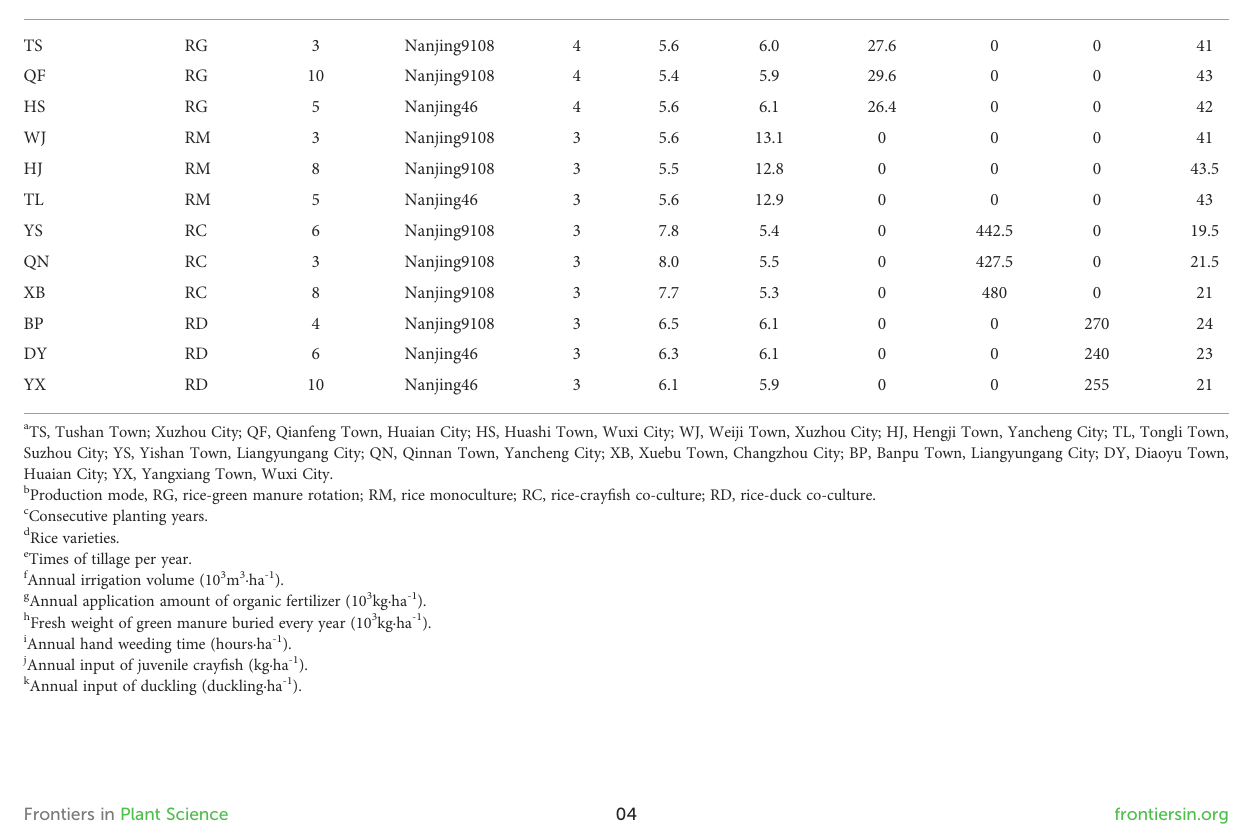
TABLE 1 The consecutive plant years and farming practices of each organic rice production mode in each sampling site. Location